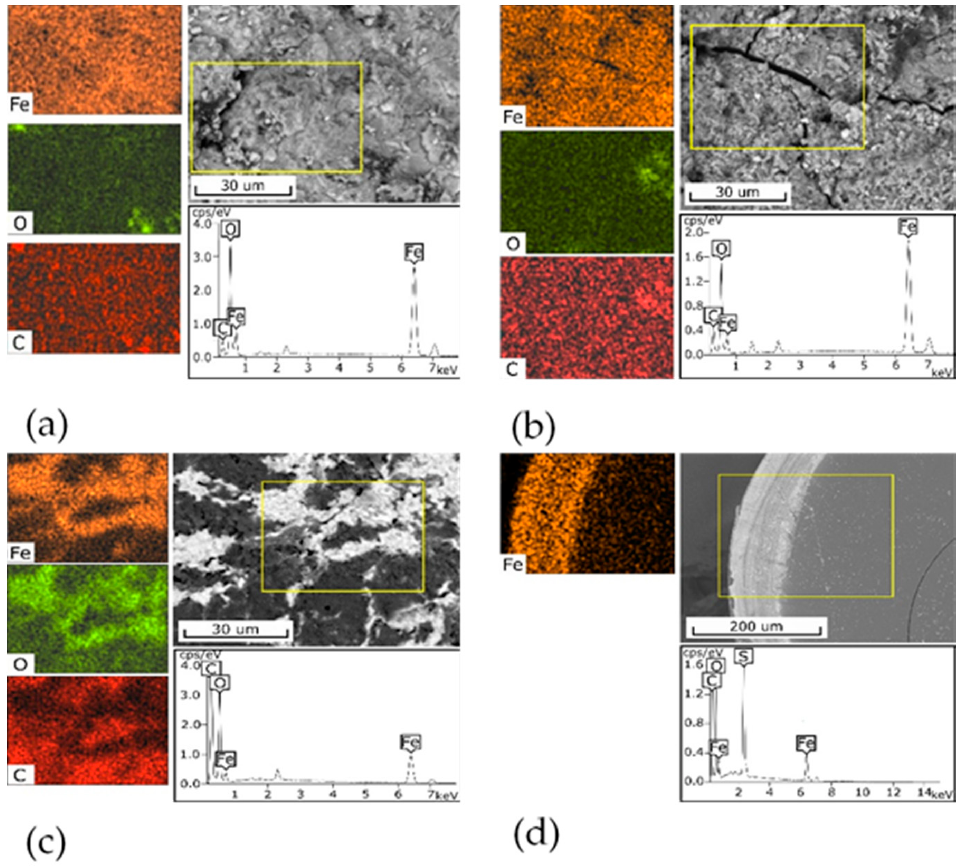
Figure 1. SEM-EDX analysis of composite sorbents, the yellow rectangle is the analysis area: ( a ) 3M, ( b ) 3M-2, ( c ) 3M-4, ( d ) KU-MAG. Scale bar ( a – c ) 30 µ m, ( d ) 200 µ m.